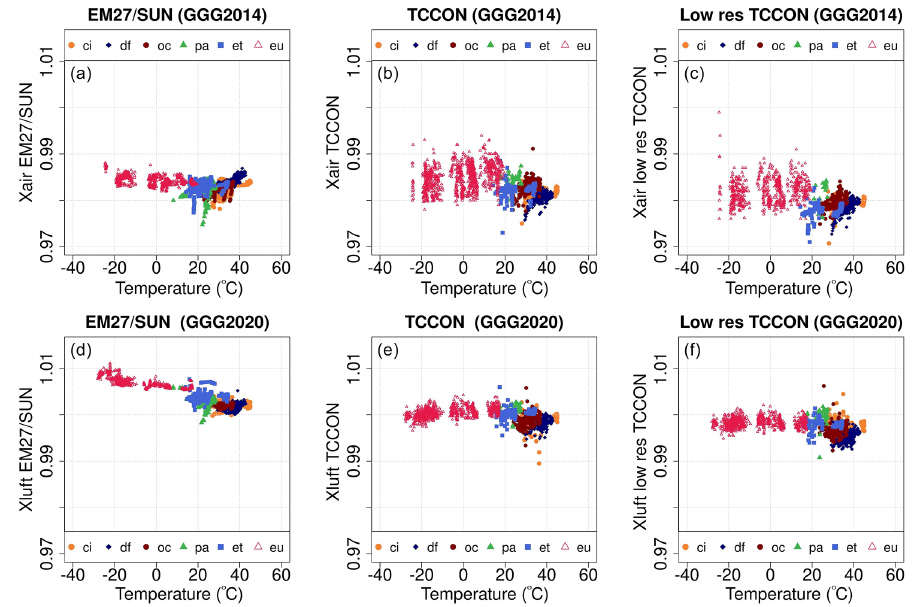
Figure 11. Xair (GGG2014) and Xluft (GGG2020) against surface temperature for the EM27/SUN devices (a, d) , TCCON (b, e) , and low-resolution TCCON (c, f)